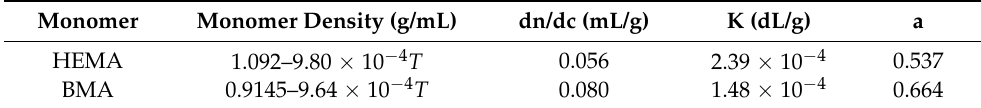
Table 1. Parameters required for k p,cop calculation from pulsed laser polymerization (PLP) experiments for butyl methacrylate (BMA)/2-hydroxyethyl methacrylate (HEMA) [14,19], with temperature T in ◦